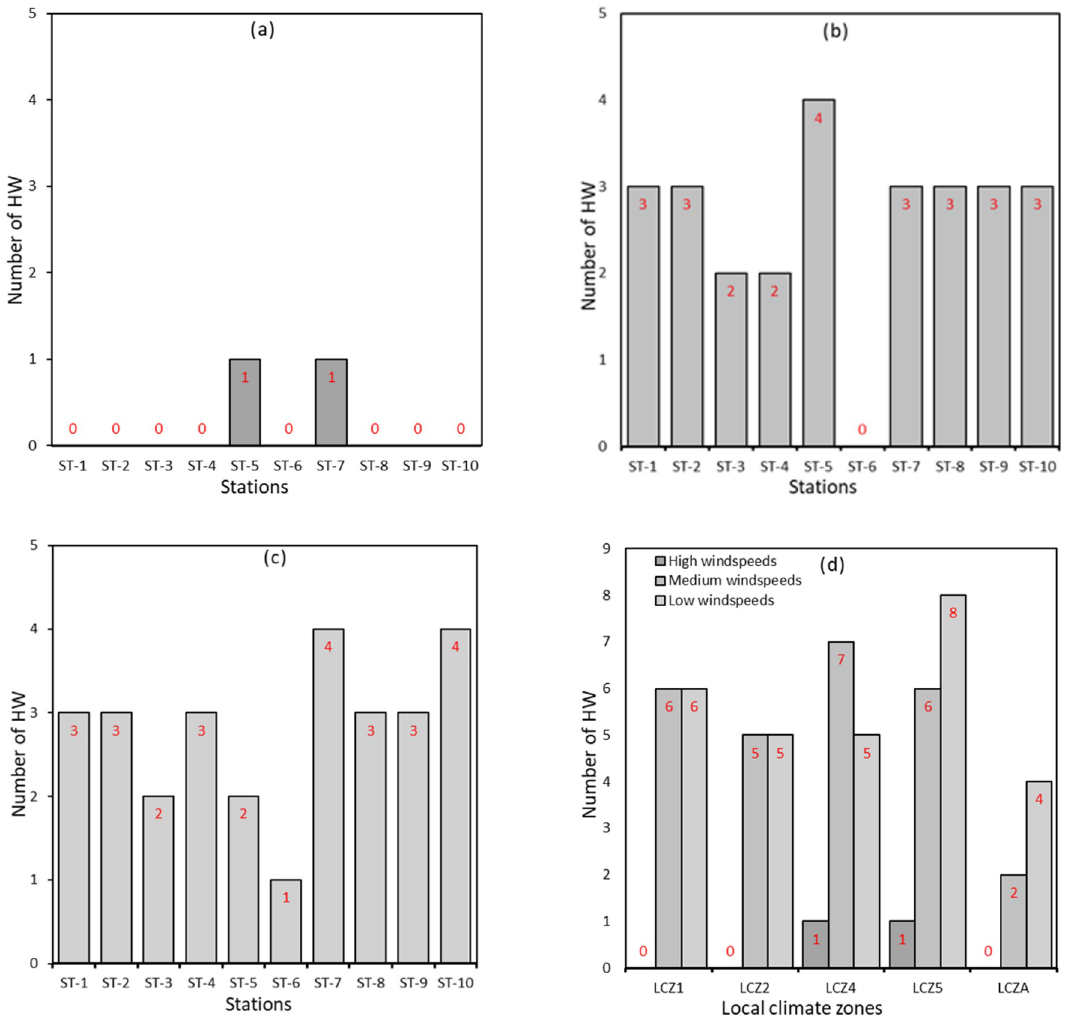
Fig 5. Frequency of HW periods under different wind speed conditions in 2016. (a) high wind speeds (b) medium wind speeds (c) low wind speeds (d) wind speed per